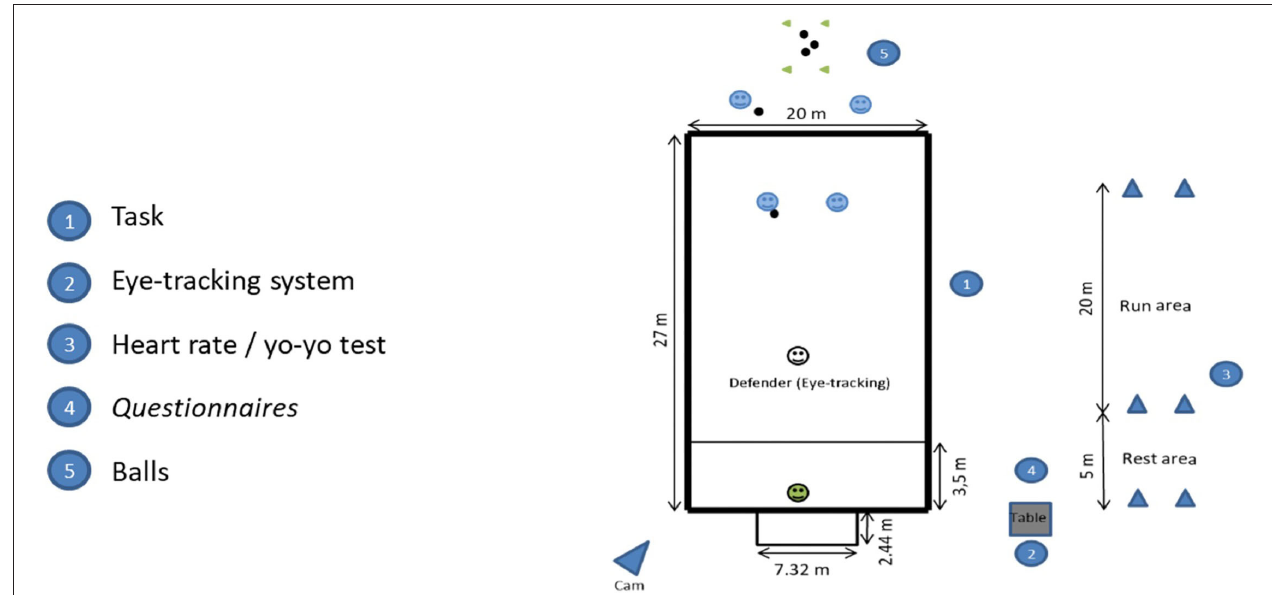
FIGURE 1 | Places where each researcher positioned himself for the experimental design to be properly controlled; pitch dimensions and its procedure representativeness (2 vs. 1 +